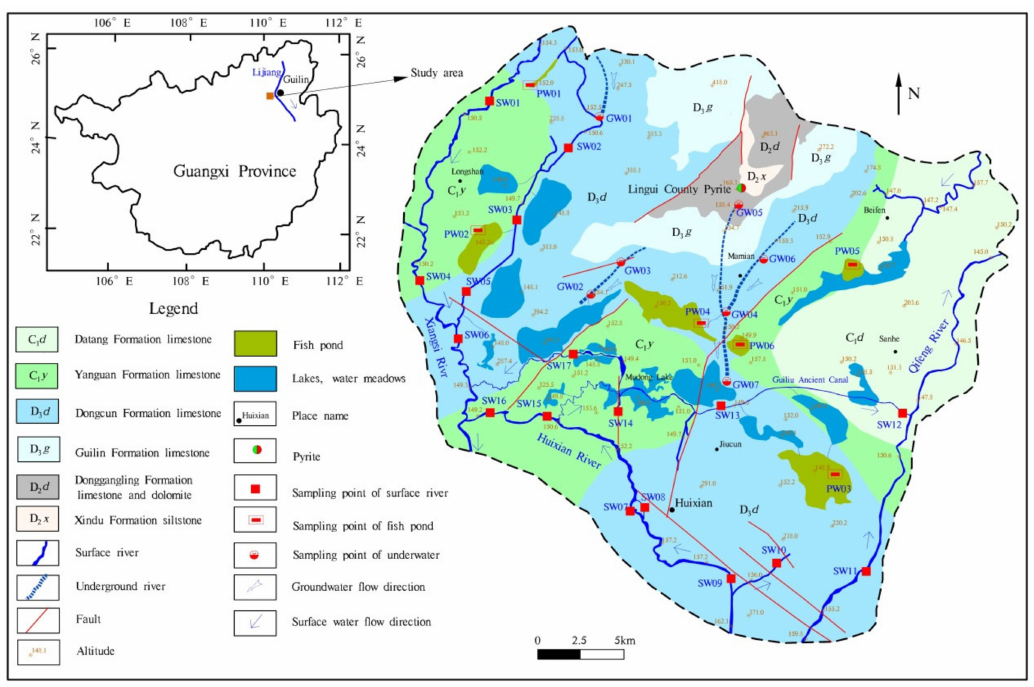
Figure 1. Hydrogeological sketch and sampling point distribution map of the study